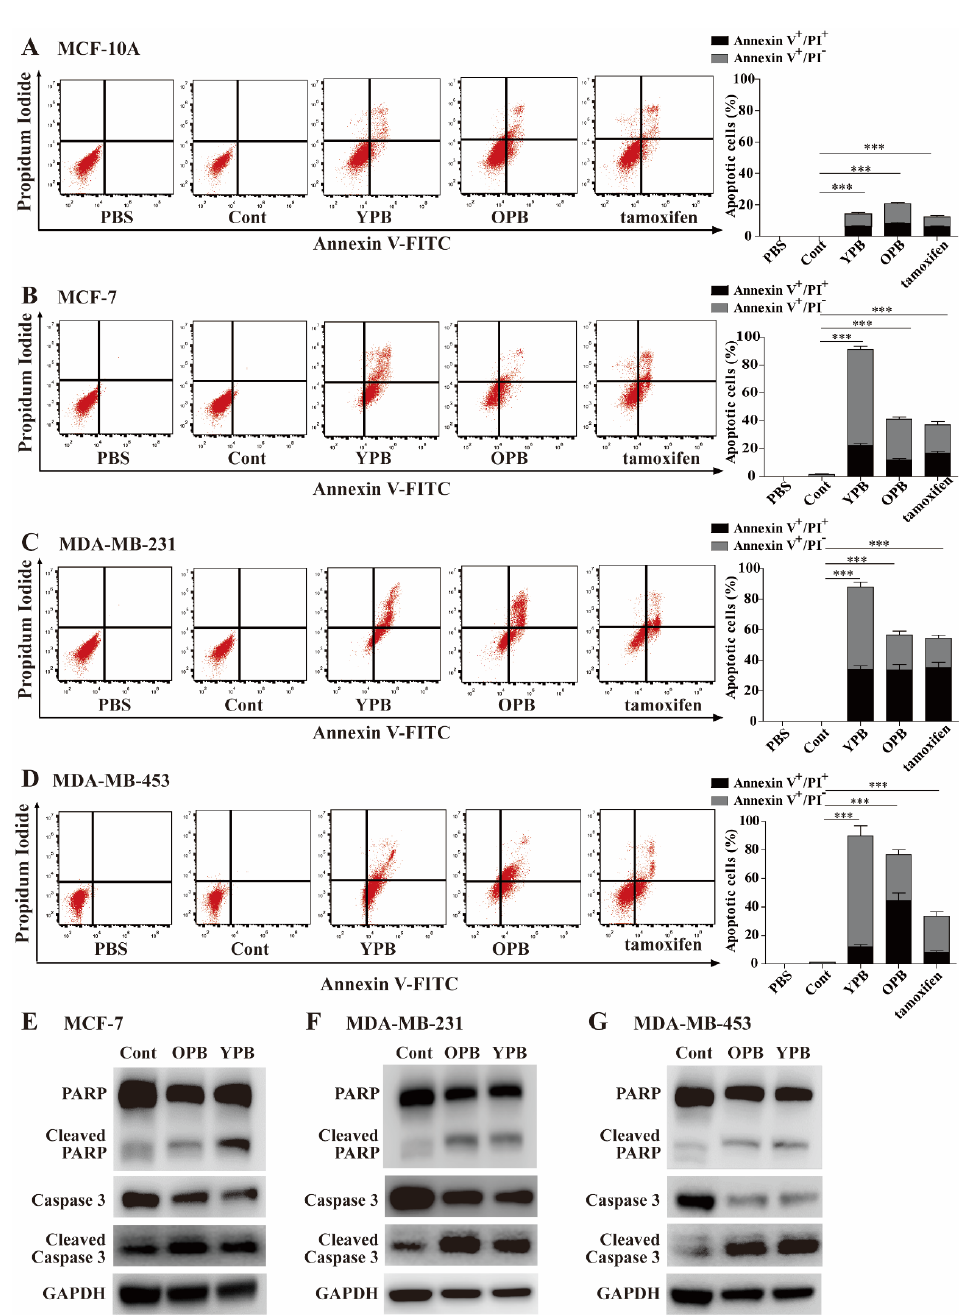
Figure 3. Evaluation of apoptosis in breast cancer cells treated by the peptides . ( A – C ) Flow cytometric analyses of breast cancer cells treated by the peptides. MCF-10A ( A ), MCF-7 ( B ), MDA-MB-231 ( C ), and MDA-MB-453 ( D ) cells were individually treated by PBS, 30 µM of Cont, YPB, and OPB peptides (unlabeled), and 15 µM of tamoxifen for 48 h, followed by the staining of Annexin V-FITC and PI. The apoptotic rates of the treated cells were analyzed by flow cytometry with representative images shown at left and quantitative apoptotic rates calculated by FlowJo software shown at right. Data represent the mean ± S.D. * p < 0.05, ** p < 0.01, *** p < 0.001. ( E – G ) Western blot analyses of apoptotic markers in breast cancer cells treated by the peptides. MCF-7 ( E ), MDA-MB-231 ( F ), and MDA-MB-453 ( G ) cells were treated as described in ( A – C ). The cell lysates were subjected to Western blot analyses using indicated antibodies with GAPDH as a loading control.